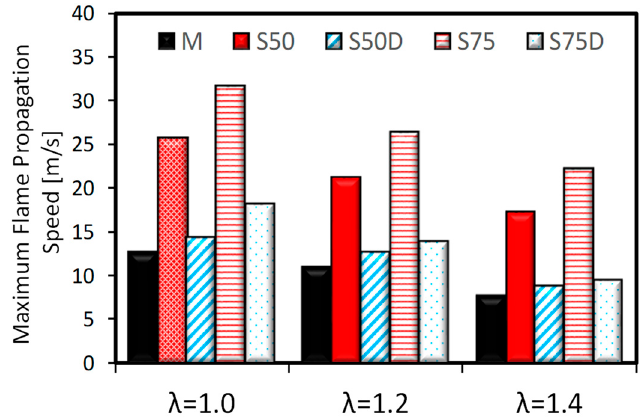
Figure 17. Maximum flame propagation speed obtained from average propagation speed data for all fuels and air-fuel ratios.